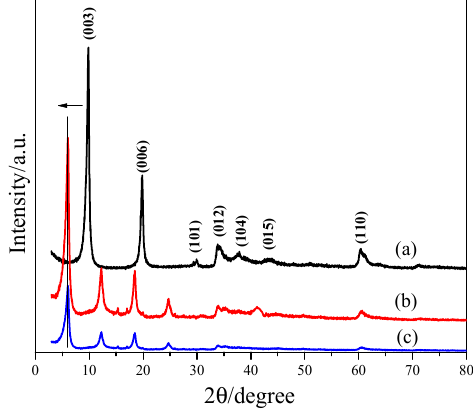
Figure 4. XRD patterns of ( a ) L1, ( b ) L2, ( c ) L2-Eu.